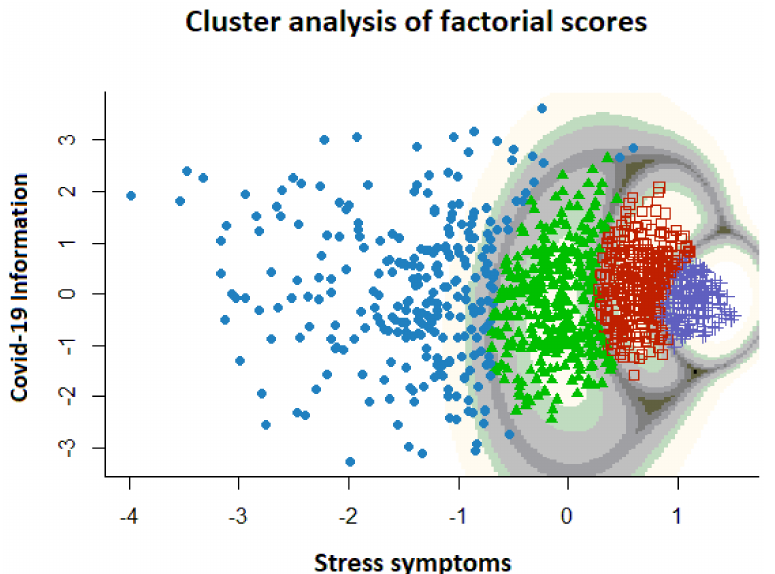
Figure 5. Results of the cluster analysis of the CPDI data conducted with the whole